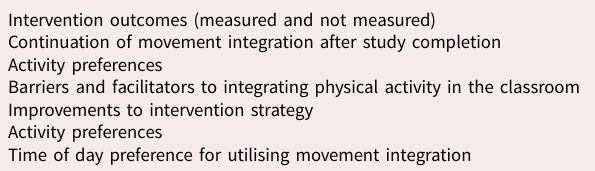
Table 2. Interview